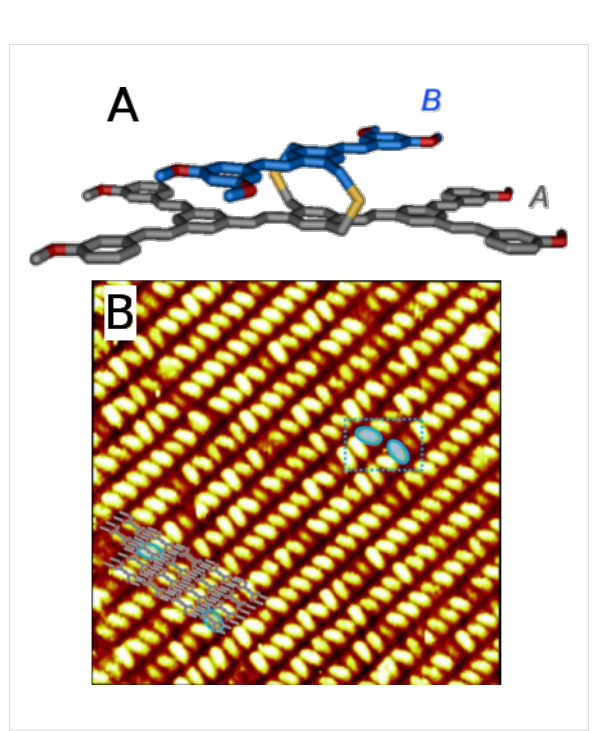
Figure 4: 3D Janus tecton: schematic structure of the two-faced building block laying on the substrate (alkyl chains are omitted for clarity), and large-scale STM image (49.3 x 49.3 nm 2 ) of the self- assembly at the HOPG–phenyloctane interface. The scaled model of the molecular assembly is superimposed on the STM picture (only lower levels A are represented for clarity). Figure adapted with permis- sion from [29], copyright 2011 Wiley-VCH Verlag GmbH &